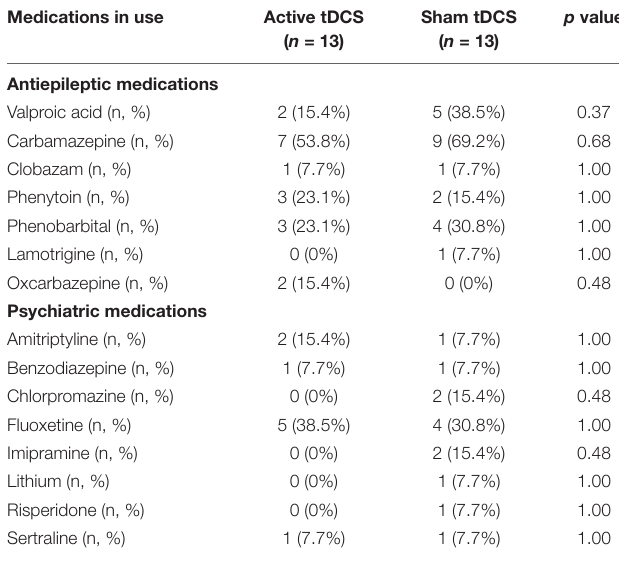
TABLE 3 | Antiepileptic and psychiatric medications in